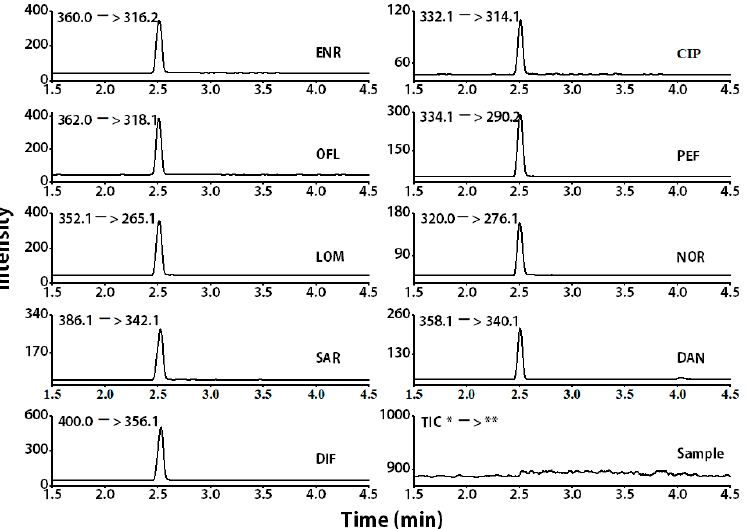
Figure 6. MS/MS spectra of all analytes in a spiked pure milk sample (spike concentration: 5.0 ng/mL). * Precursor ion, ** Product